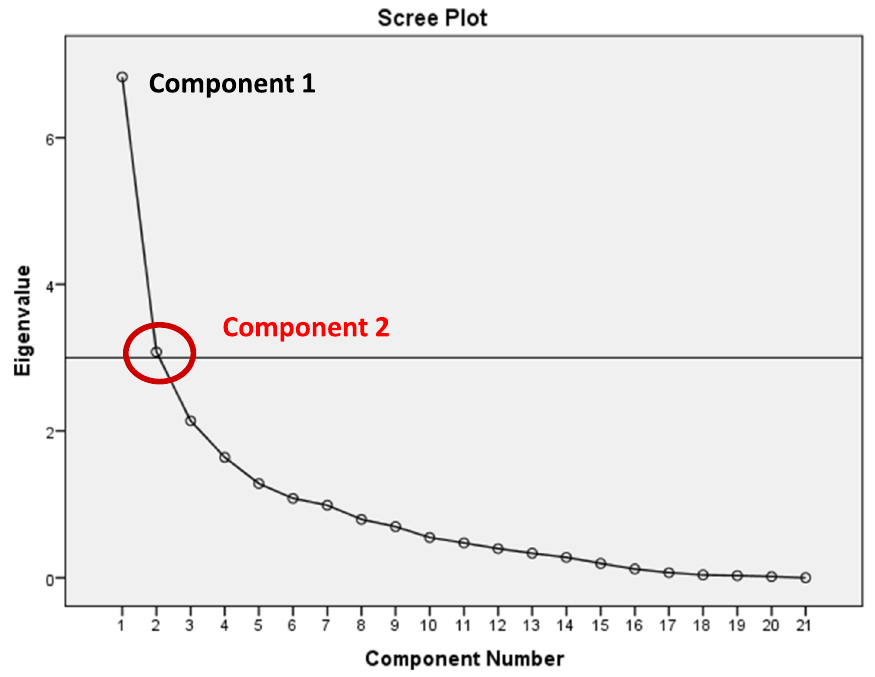
Fig. 5 Scree plot for the first runs